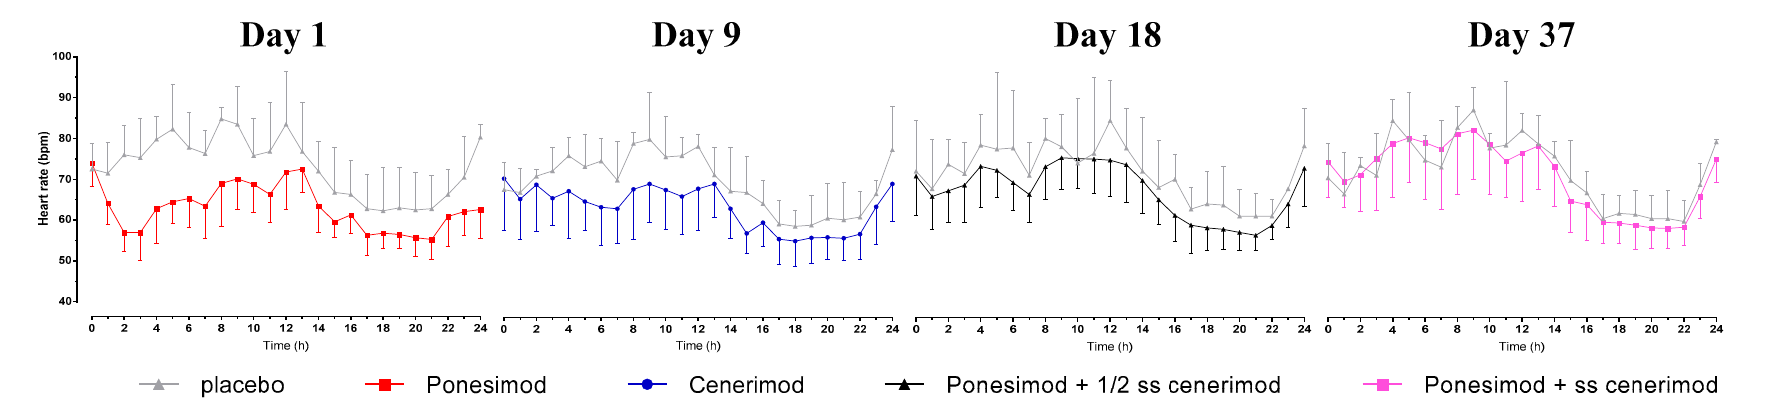
Figure 1. Hourly mean heart rate profile over 24 h by treatment group. Arithmetic mean heart rate versus time profiles following single-dose administration of 10 mg ponesimod alone (Day 1, red curve), at approximately 50% steady state of 2 mg once daily cenerimod (Day 18, black curve), at steady-state cenerimod (Day 37, pink curve), and following first-dose administration of cenerimod (Day 9, blue curve), n = 8. Placebo data of the corresponding days are displayed in grey ( n = 4). Data were derived from 24 h Holter ECGs. Error bars represent standard deviation.